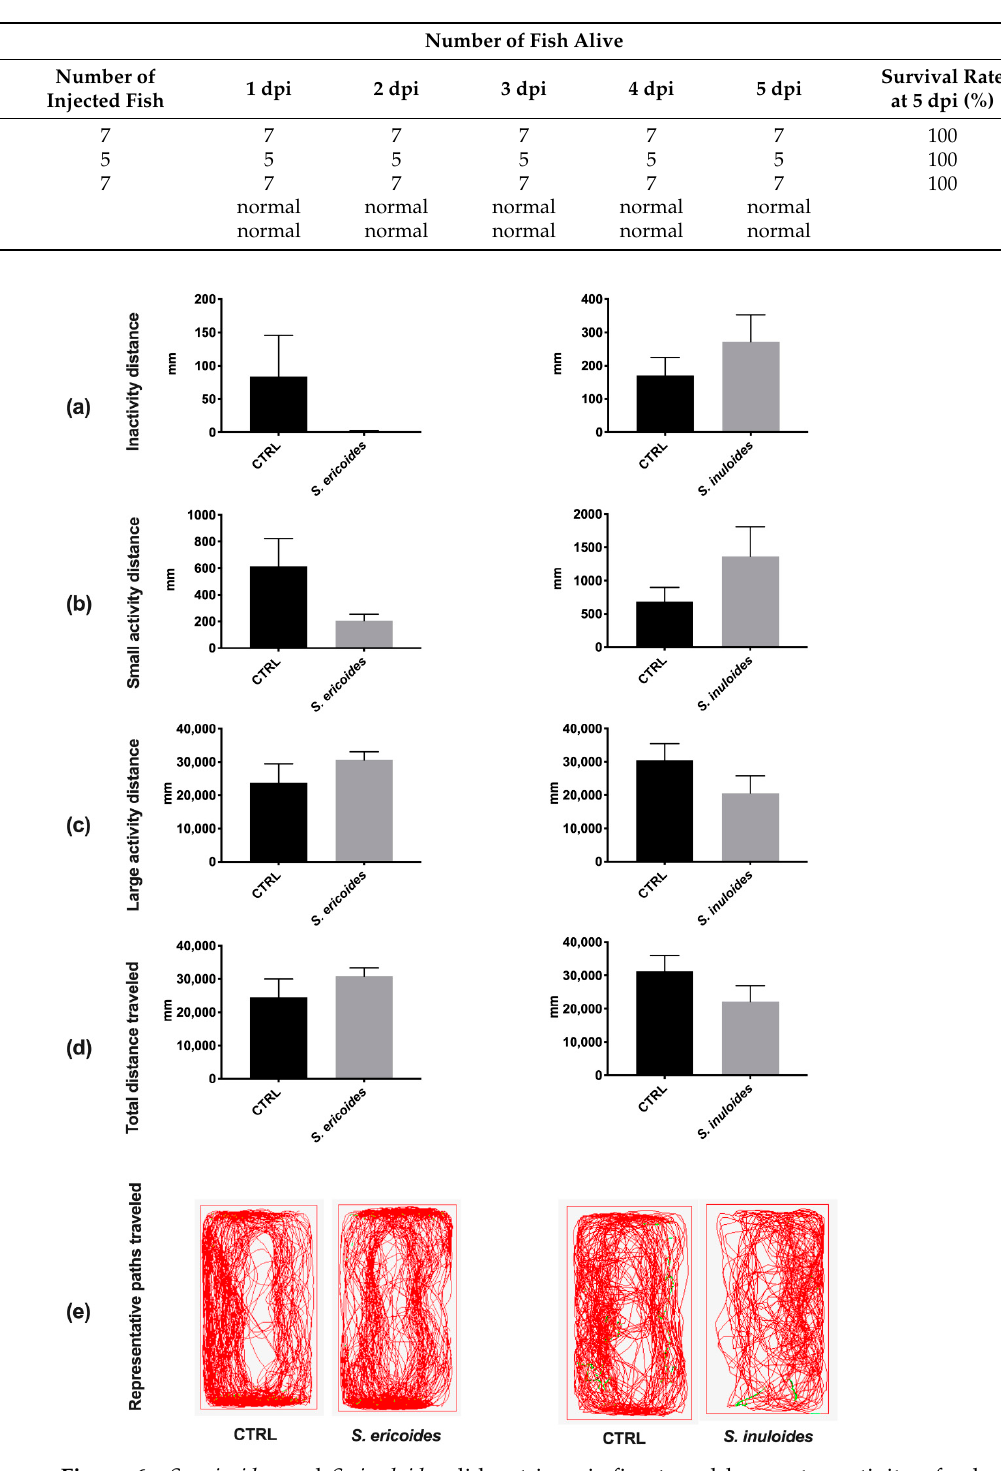
Figure 6. S. ericoides and S. inuloides did not impair fine-tuned locomotor activity of zebrafish ( a ) Inactivation time (<4 mm.s − 1 ). ( b ) Time of small activity (4–8 mm.s − 1 ). ( c ) Time of large activity (>8 mm.s − 1 ). ( d ) Total distance traveled at 1 day post injection. No significant differences were observed compared with the PBS-injected fish (Vehicle). ( e ) Representative paths traveled by PBS-injected fish and S. ericoides and S. inuloides extract-injected fish at 1 day post injection. Statistical analyses were conducted using unpaired t-test comparisons, n = 5 ( n : number of fishes per group).